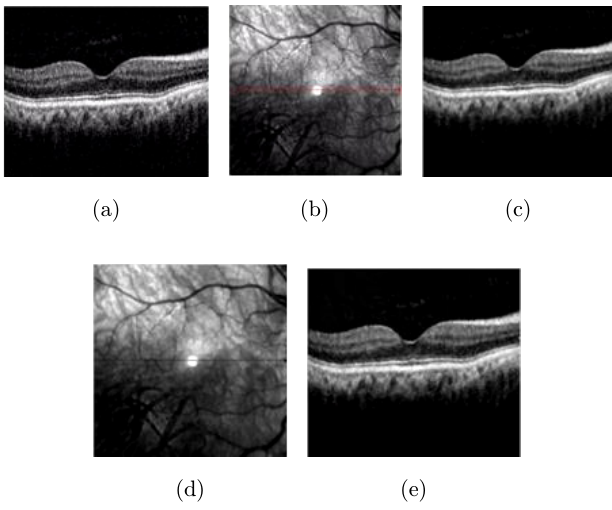
Fig. 8. (a) Original OCT image, (b) original retinal image, (c) pre-processed OCT image, (d) pre-processed retinal image, and (e) embedded image for authentication.